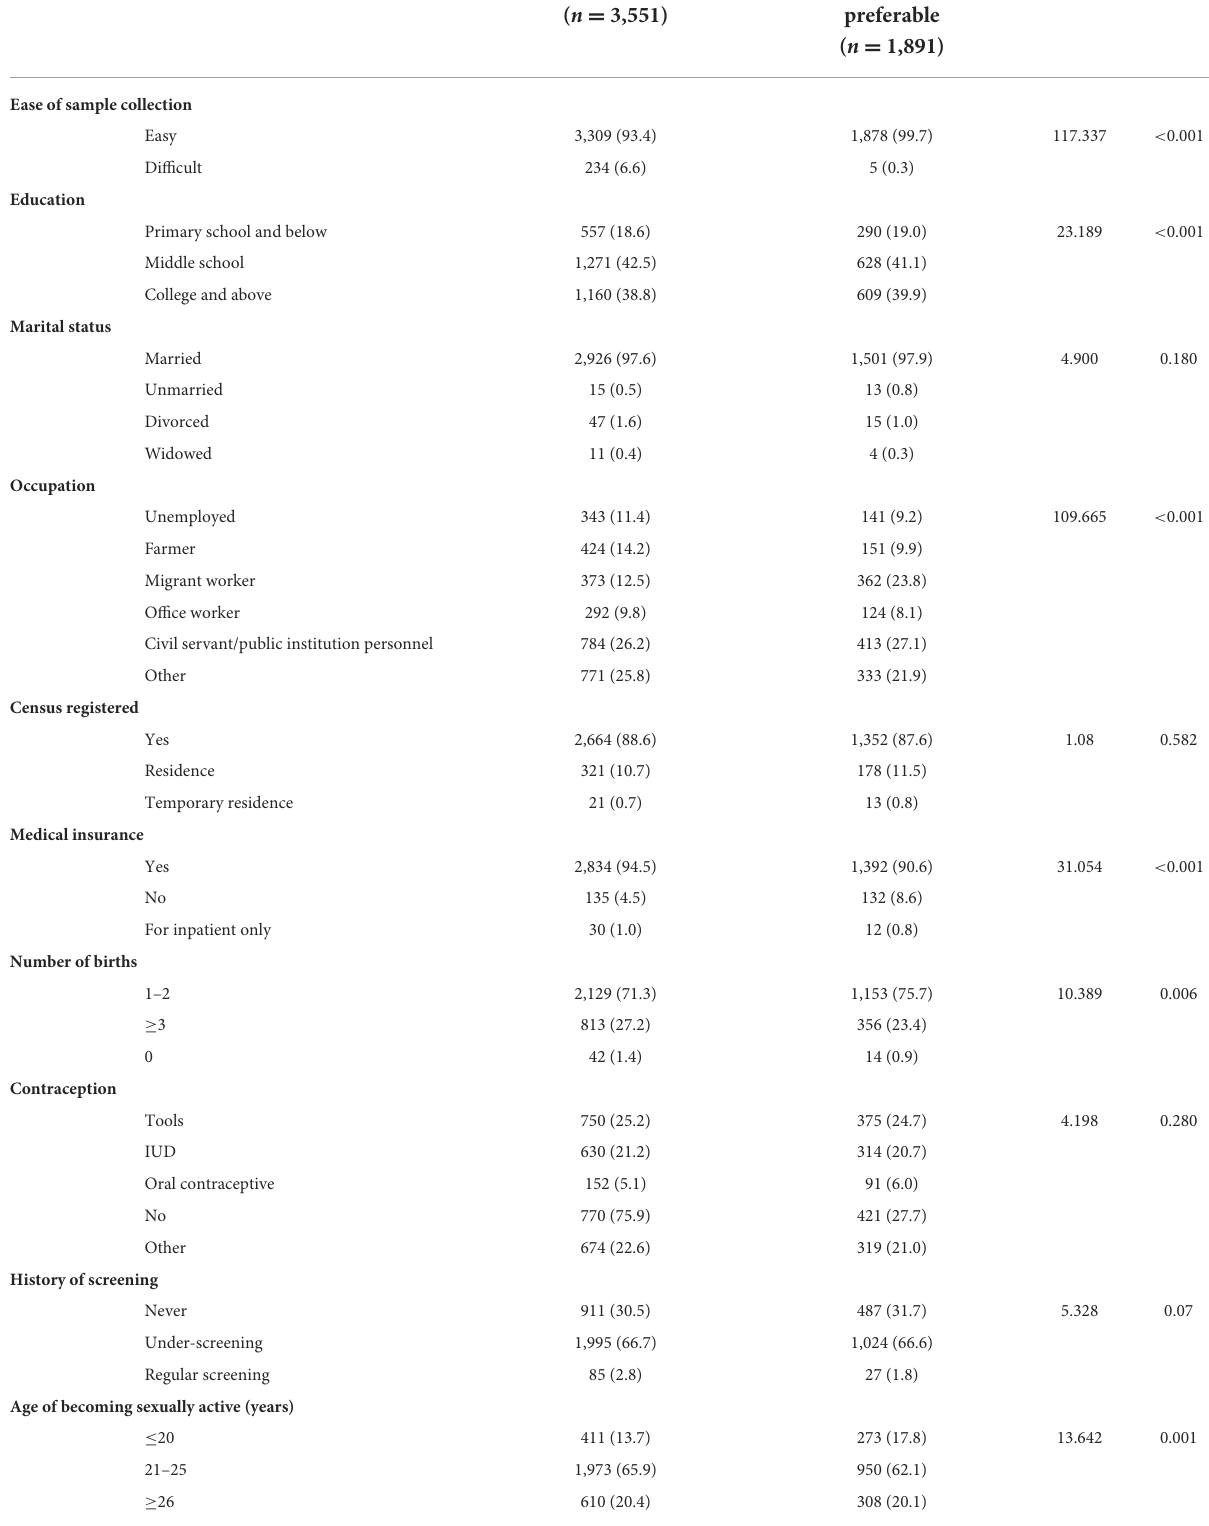
Self-sampling preferable Provider-collection ( n = 3,551)